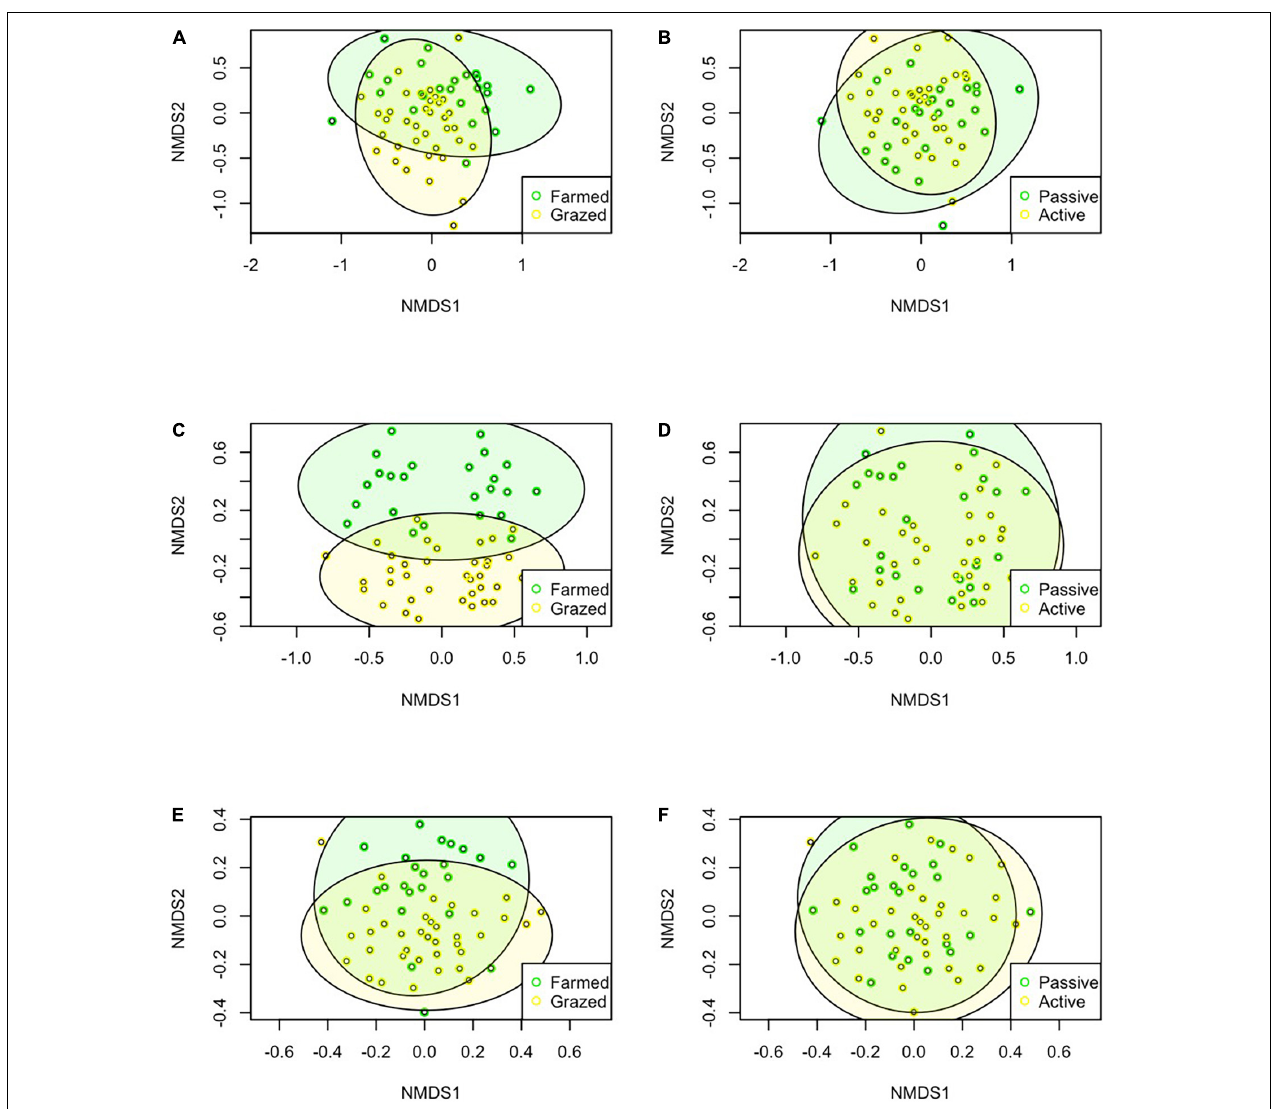
FIGURE 4 | NMDS plots showing the differences between communities for plants between the historic land-use types (A) and current management types (B) , for trapped pollinator communities between historic (C) and current (D) , and for netted pollinators for historic (E) and current practices (F)